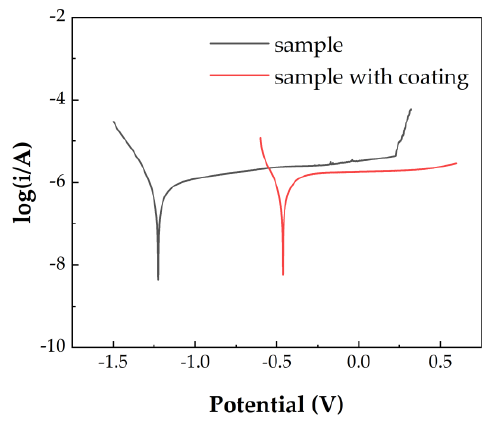
Figure 6. Tafel curves of the high entropy alloy (HEA) thin film and the Zr-4 alloy substrate in 3.5 wt.% NaCl solution at room temperature.